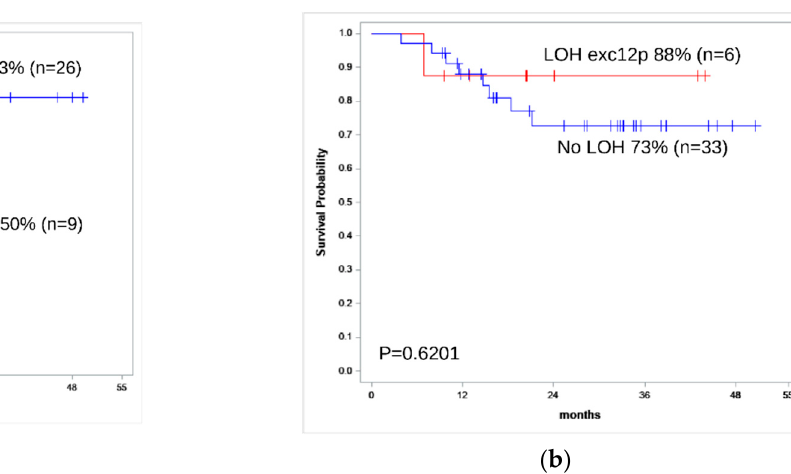
Figure 3. Kaplan–Meier survival curve for OS estimates according to the LOH status in tumor STR profile for B-ALL ( a ) and T-ALL ( b ) patients. Patients 3, 4, 43, and 65 were excluded from the LOH group due to 12p